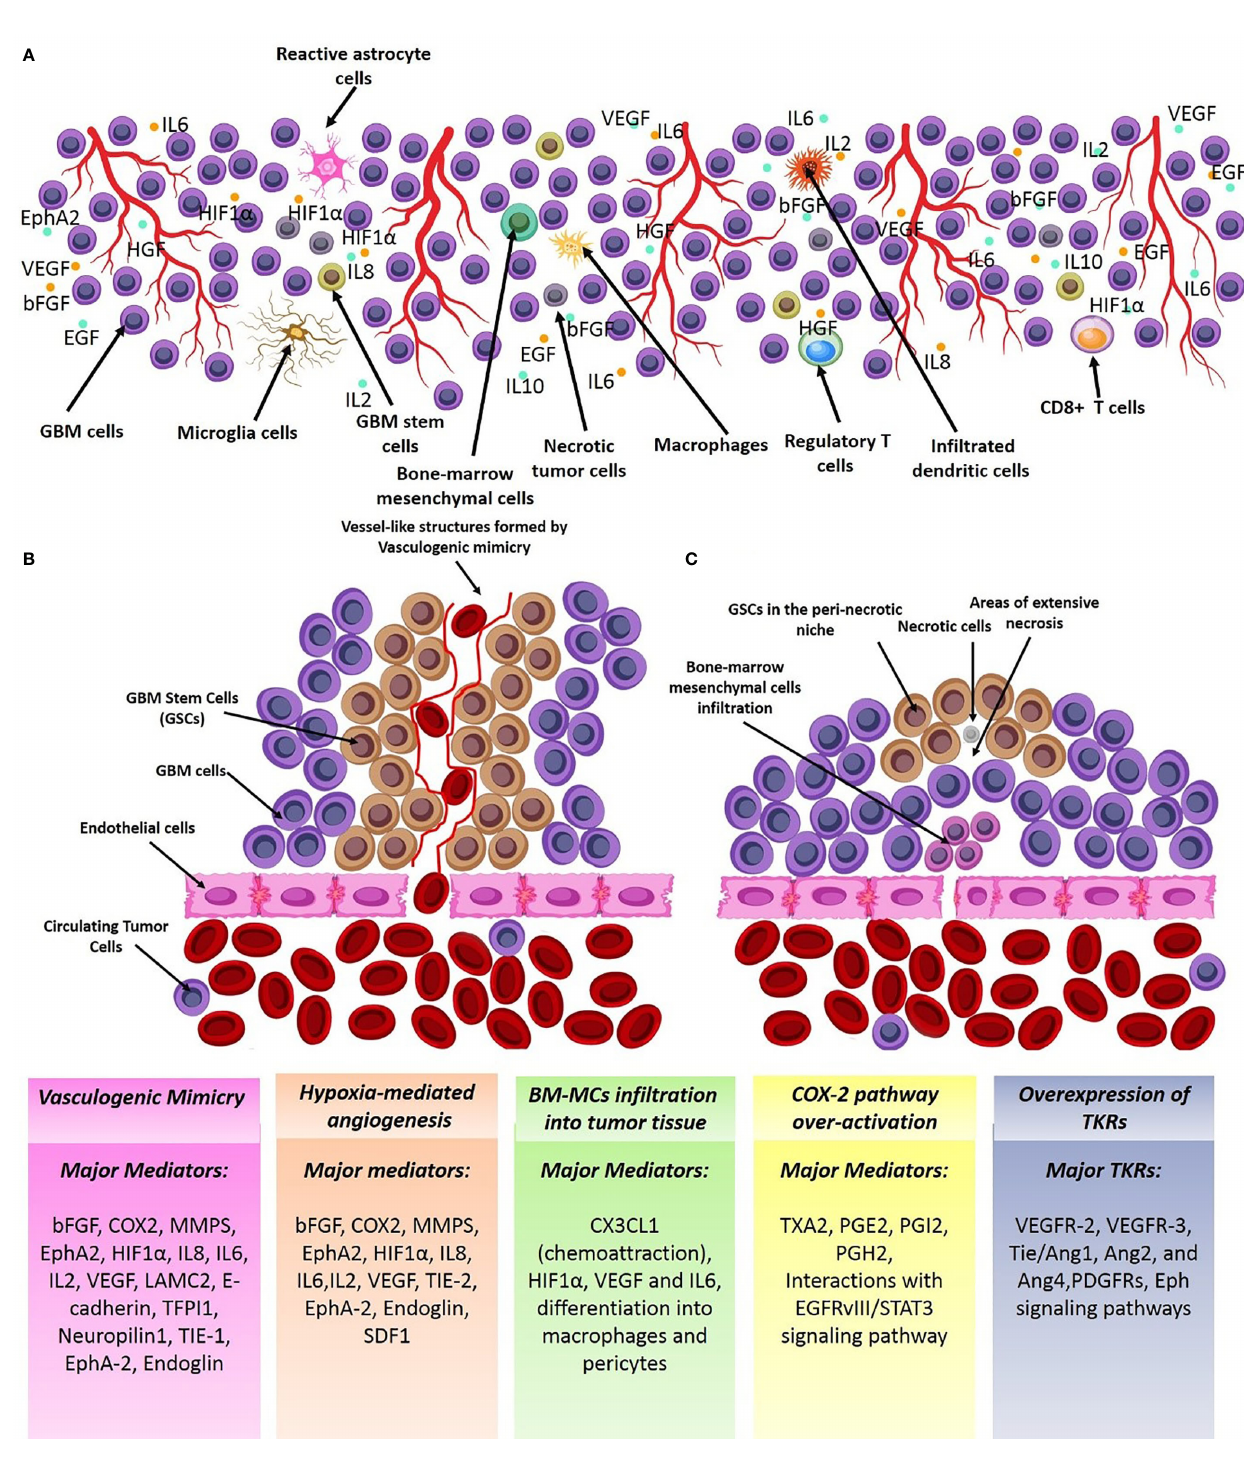
FIGURE 1 | Major mechanisms of GBM angiogenesis. (A) Cellular schema of the angiogenic tumor microenvironment (TME) of GBM. GBM TME consists numerous cell sources (e.g. immune cells, GBM cells, astrocytes, macroglia/macrophages, and astrocytes) which support the angiogenic TME by overproducing angiogenic cytokines. (B) Vasculogenic mimicry; GSCs form vessel-like structures which invade to tumoral endothelia to get nutrient and oxygen supply. (C) Chemical attraction and in fi ltration of angiogenic clones of BMSCs in the tumor tissue by TME chemotactic signals. Some of the vectors used to design this fi gure were downloaded from Vecteezy under a free